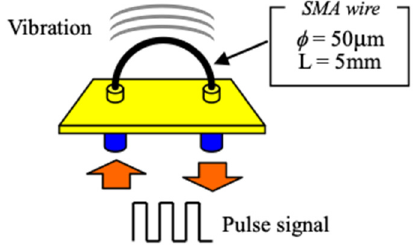
Figure 2. SMA vibration actuator.